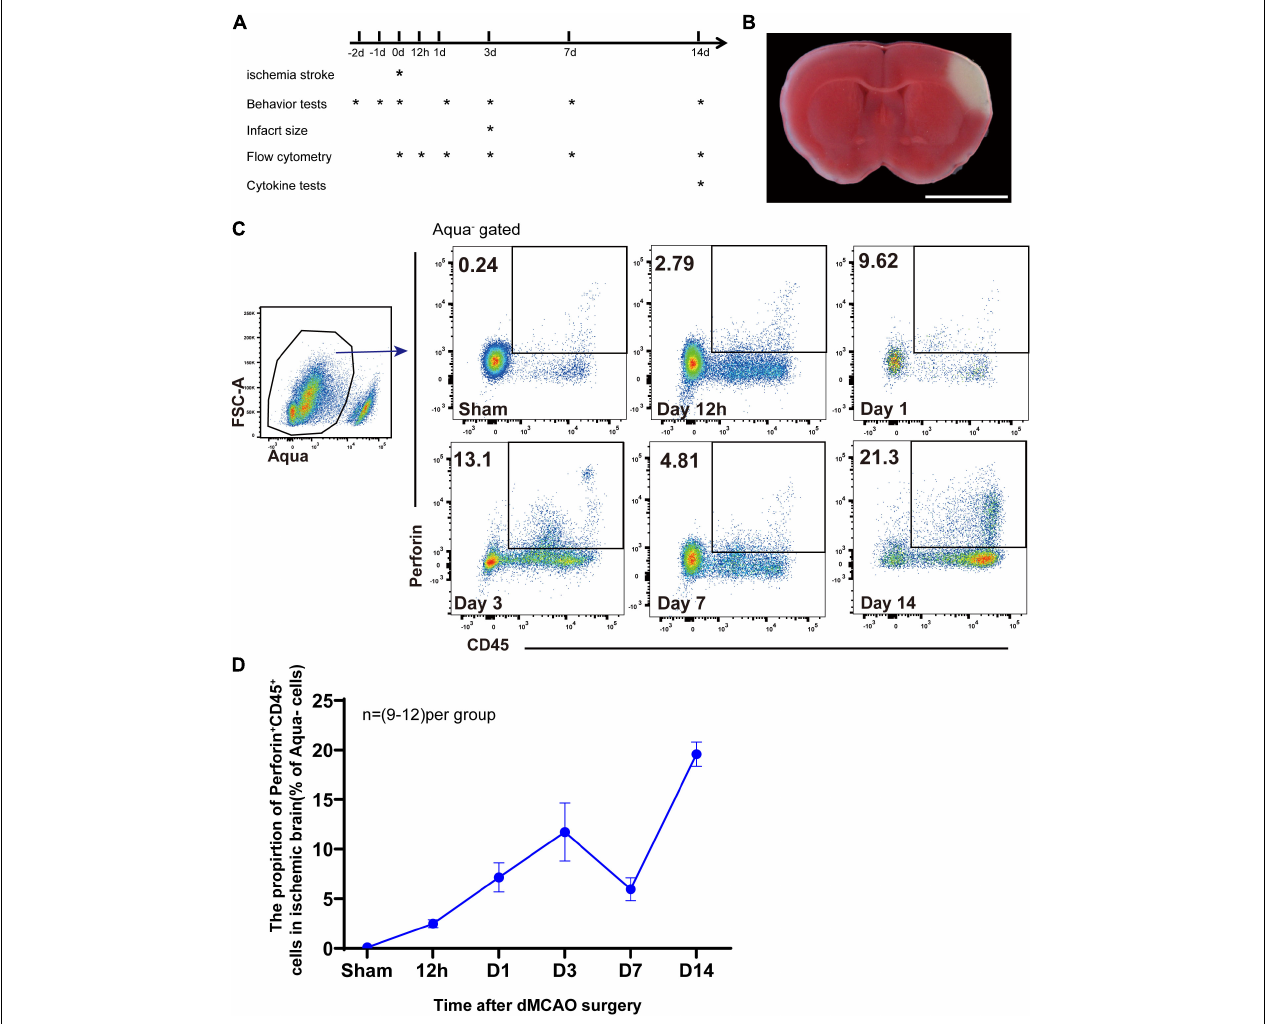
FIGURE 1 | Accumulation of perforin + CD45 + cells in the ischemic brain. (A) Scheme for experimental design in a model of dMCAO. The timeline for outcome measurements is also illustrated. (B) Flat pattern of lateral ventricle cross-sections from mice subjected to dMCAO. Scale bar = 5 mm. (C) The proportion of live cells (FSC-A, Aqua - ) expressing Prf1 (Prf1 - GFP + CD45 + ) in the brain after dMCAO at six time points (sham, 12 h, day 1, day 3, day 7, and day 14) was assessed by flow cytometry. (D) The line chart shows the change in the number of Prf1-GFP + CD45 + cells at specific time points after surgery. The data are shown as the mean ± SEM; n = (9–12) mice per